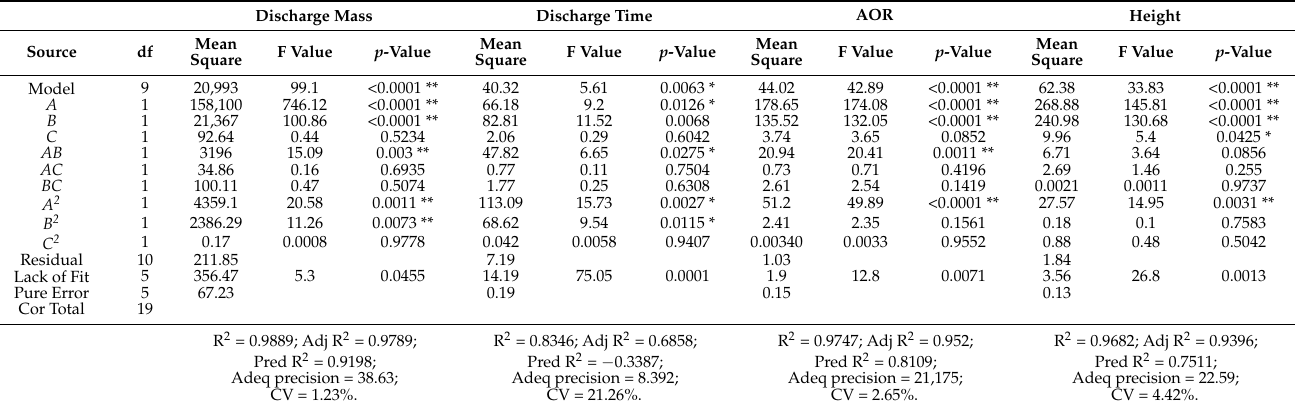
Table 5. Analysis of variance of the results of the sandglass